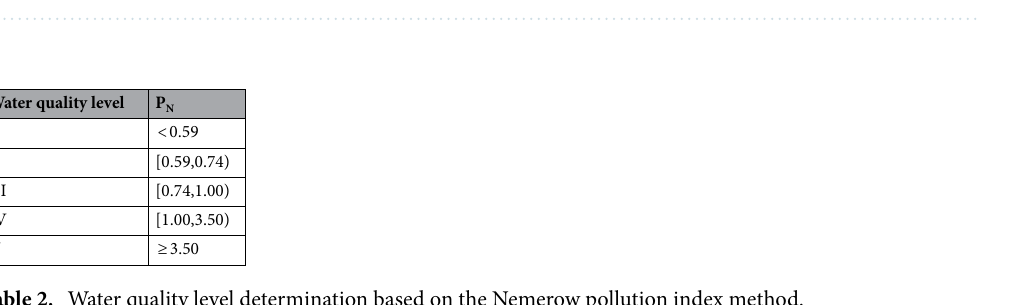
Table 1. Water quality level determination based on the single factor pollution index method.